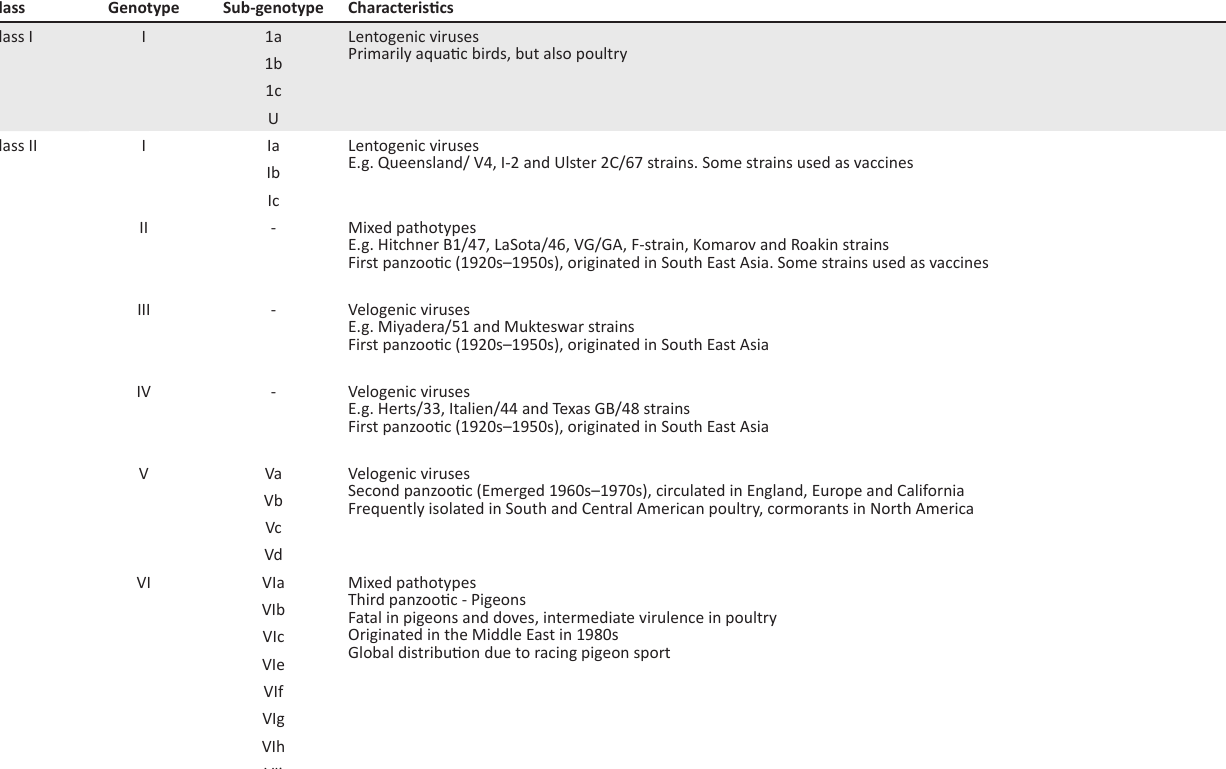
TABLE 1: Current classification of avian paramyxovirus type 1 (Newcastle disease virus). Class Genotype Sub-genotype